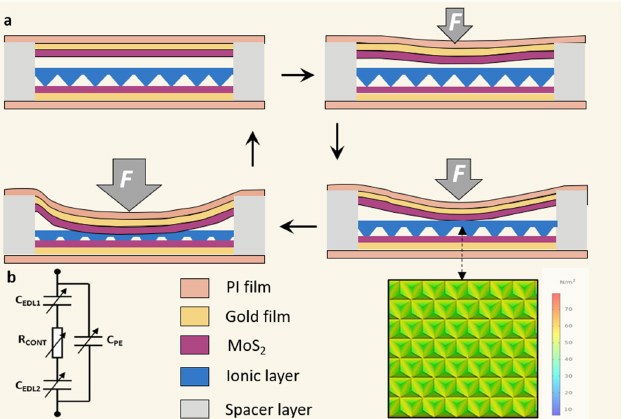
Figure 6. Schematic illustration of the working mechanism of the sensor. ( a ) Sensing mechanism of the iontronic pressure sensor and the stress concertation of the microstructure. ( b ) Corresponding capacitance variation of the